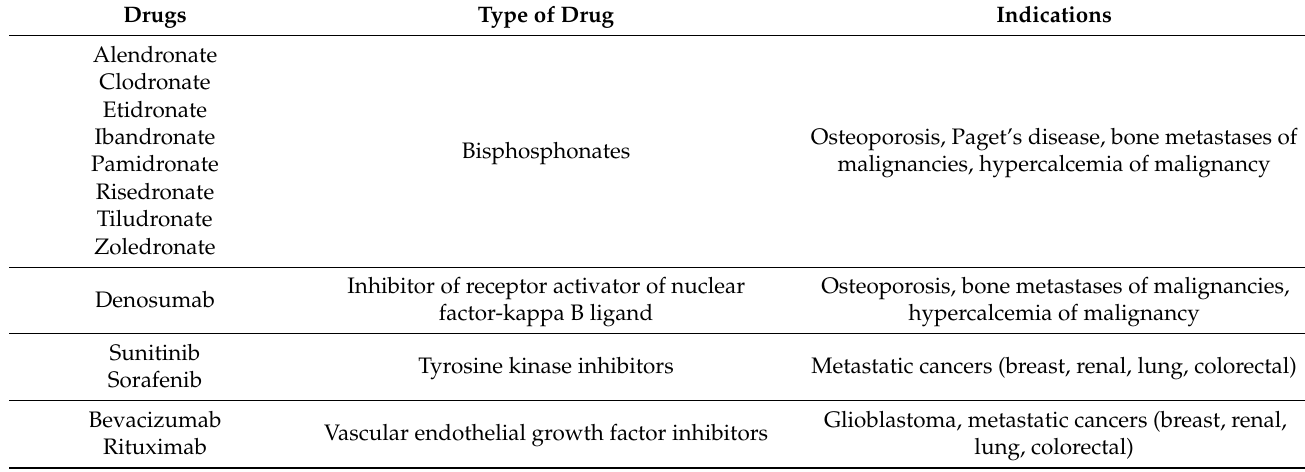
Table 1. Drugs are known to be associated with MRONJ.